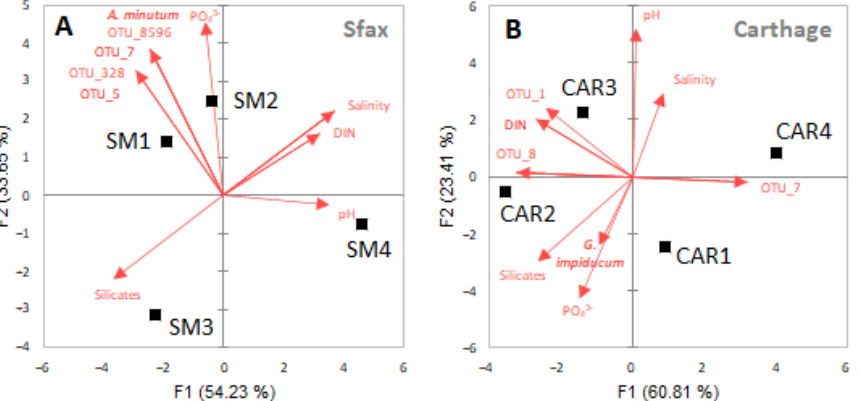
Figure 7. Principal component analysis (PCA) biplots showing the variation among the samples based on the relative abundances of microorganisms and environmental variables. Black squares represent samples from Sfax ( A ) and Carthage ( B ). Arrows indicate the direction of the maximum increase and strength (through the length) of each variable to the overall distribution.